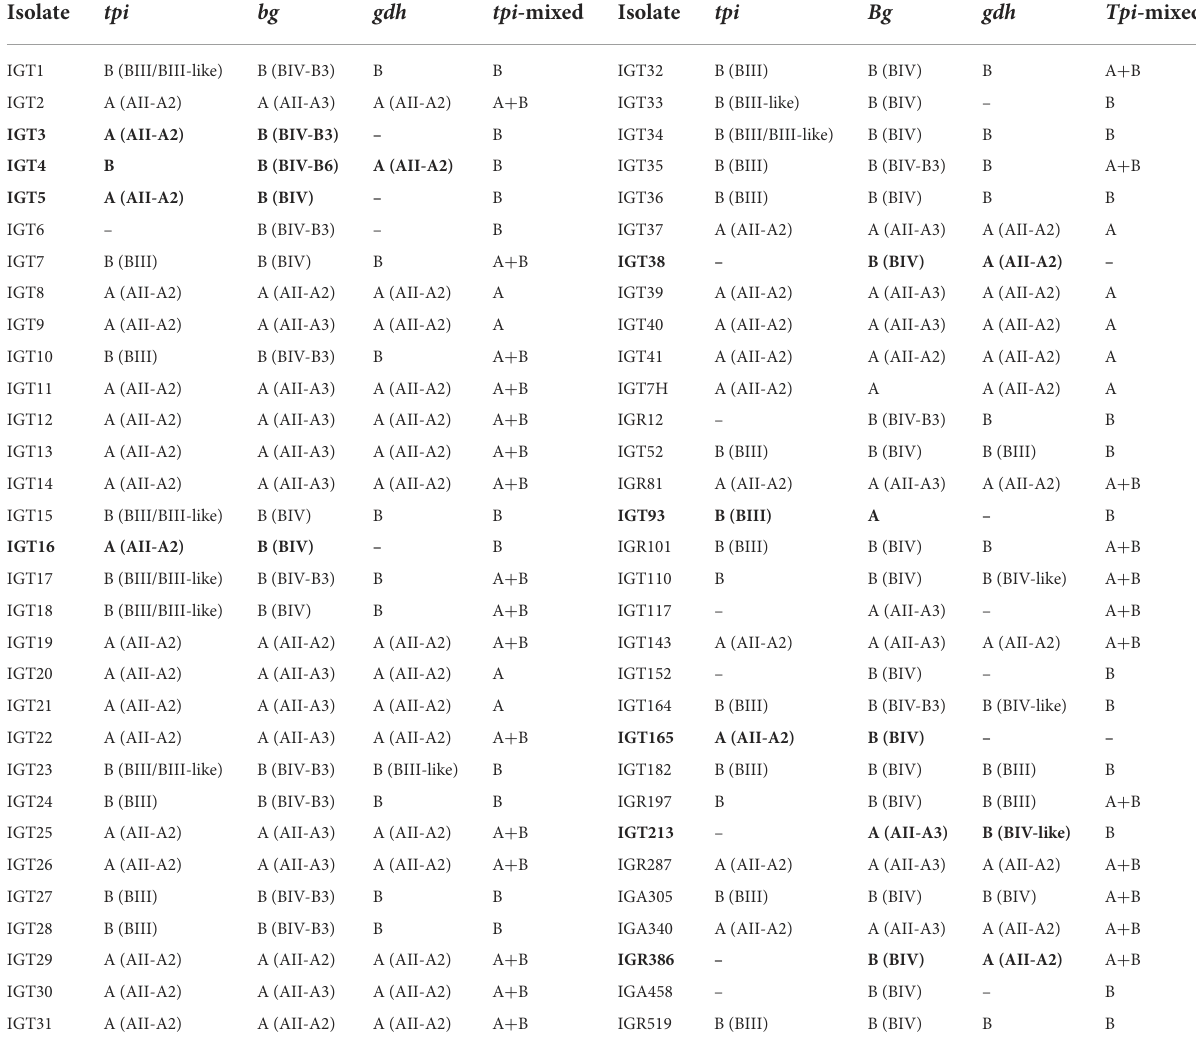
TABLE 2 Assemblages (subassemblage-subtype) A and B identification based on tpi , bg, and gdh loci and mixed A and B infections according to tpi A and B assemblage-specific primers. Isolate